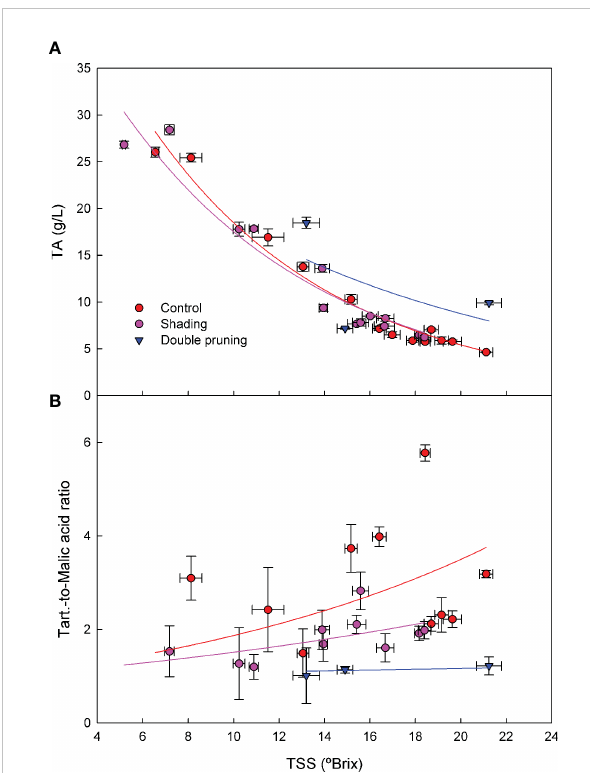
FIGURE 5 Effect of shading ( (cid:129) ), double pruning, ( ▼ ) and control ( (cid:129) ) treatments on the relationship between (a) TSSs and TA and (b) TSSs and tartaric-to- malic acid ratio for ‘ Macabeo ’ grapes in the 2017 – 2019 seasons. Data are the average offour replicates per treatment and date. TA, titratable acidity; TSSs, total soluble